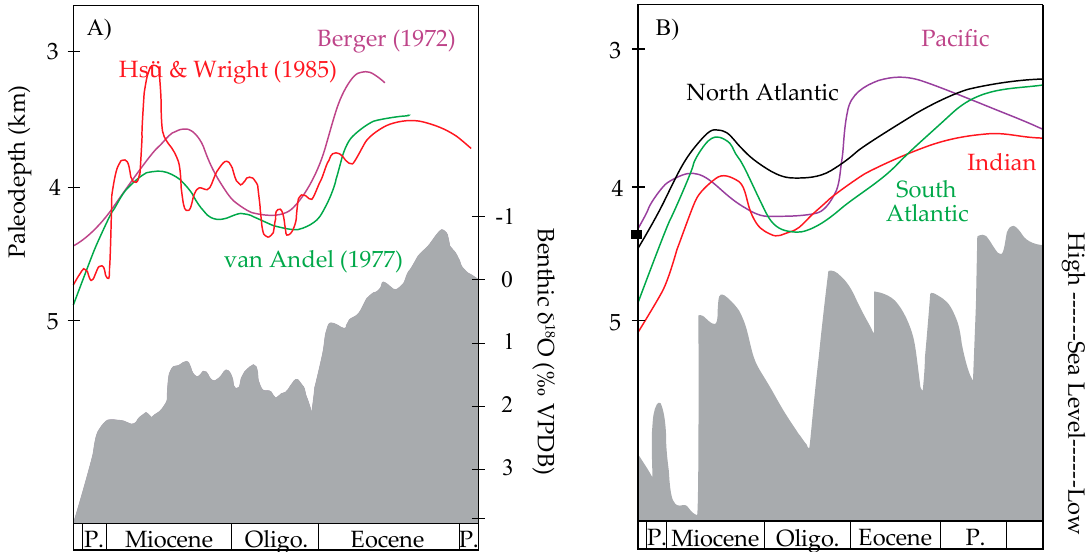
Figure 1. ( A ) Calcite Compensation Depth (CCD) reconstructions of the South Atlantic from Berger [83] , Van Andel, et al. [86] , and Hsü and Wright [87] . ( B ) Compiled CCD reconstructions for the mains oceans after Berger and Wefer [85] .